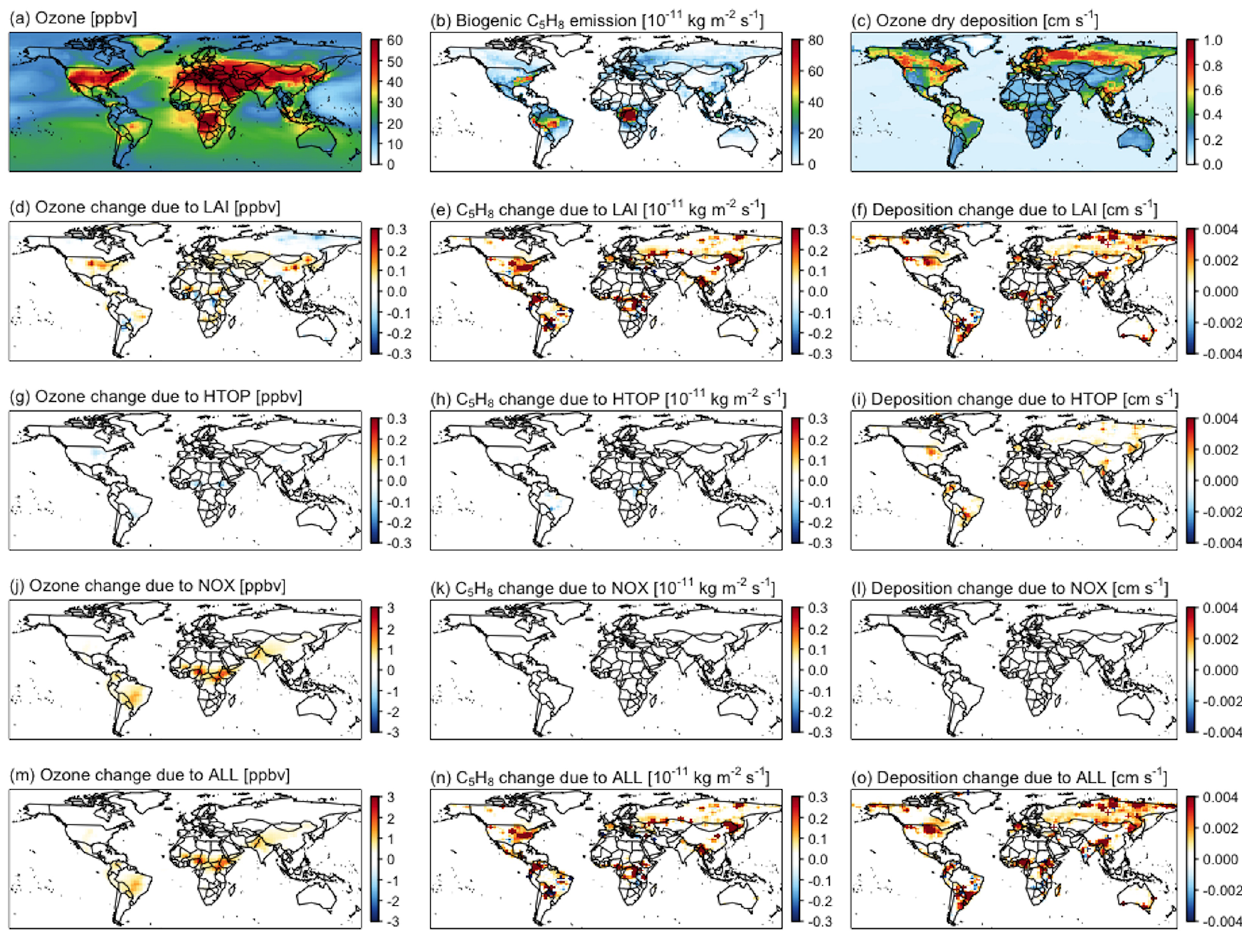
Figure 5. Year 2000 summertime (June–July–August; JJA) level of (a) surface ozone concentration, (b) biogenic isoprene emission, (c) ozone dry deposition, and their corresponding changes due to nitrogen-mediated increases in LAI only (d, e, f) , canopy height only (g, h, i) , soil NO x emission only (j, k, l) , and the combination of increases of all elements (m, n, o) with the prescribed